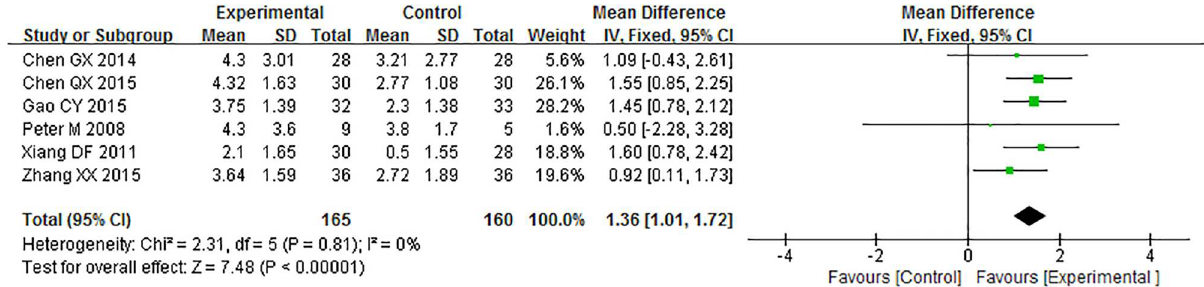
Fig 4. Meta-analysis of the variation in main pain level.